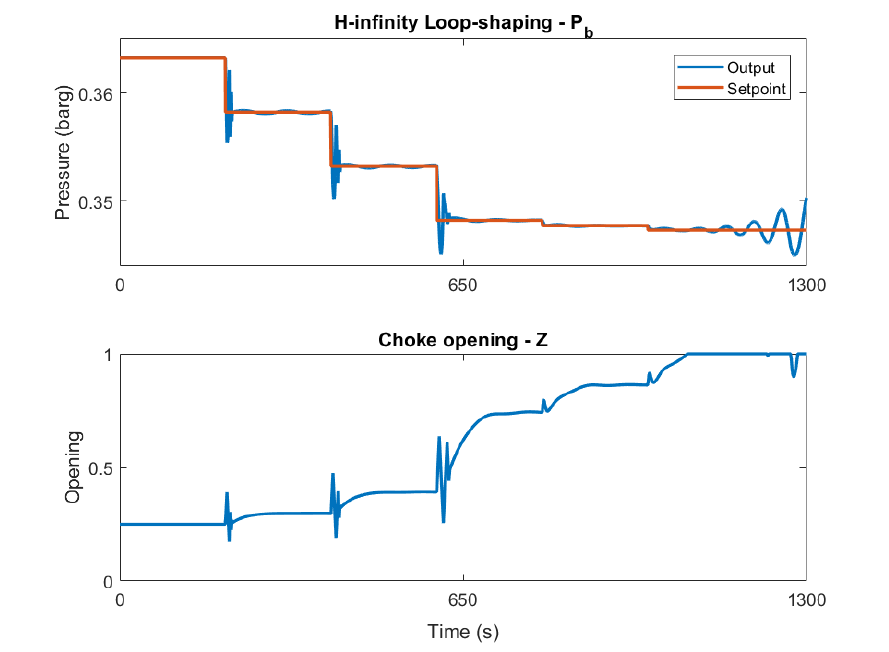
Figure 7. The non-linear model with the loop-shaping controller for P b . The setpoint is stepped to find highest allowed valve opening. At 1000 s the system cannot stabilize due to the saturation of the choke